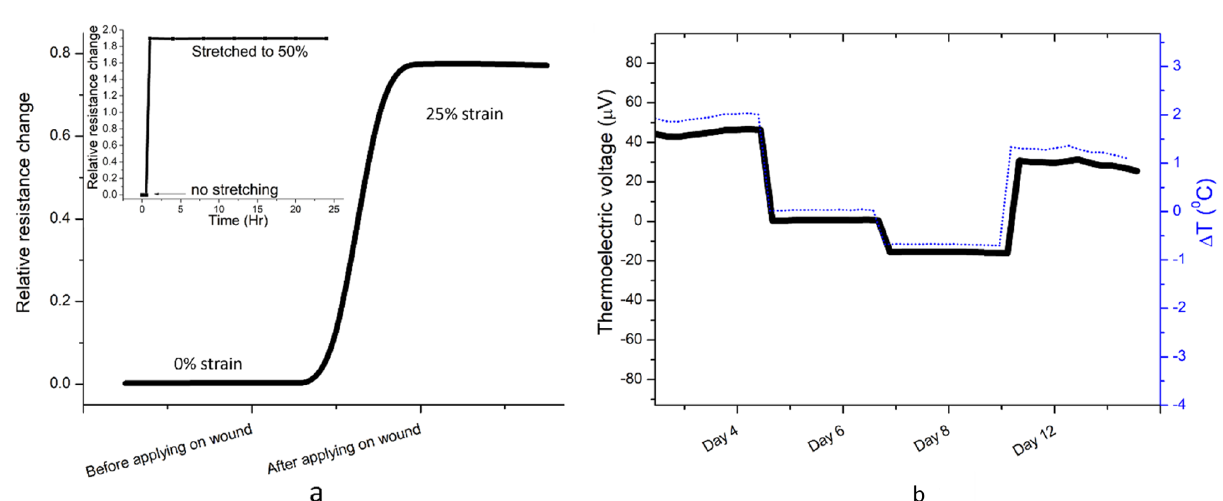
Figure 10. Strain induced resistance change upon applying the sensor on mice body ( a ), sensor resistance change is measured while it is elongated to 50% using a stretch bench and maintained it in the same position for 24 h ( a , insets). Thermoelectric voltage generated during the test period of 4–12 days and corresponding ΔT is also shown in b